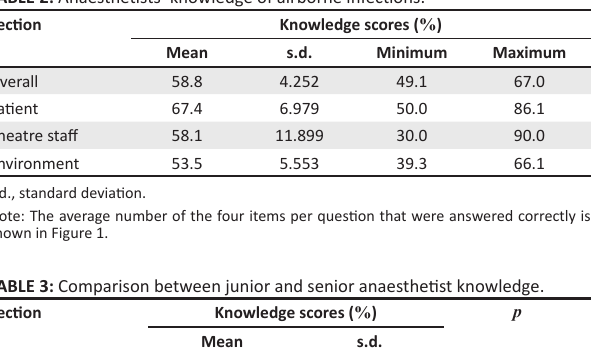
significantly better than that about theatre staff ( p < 0.0005)